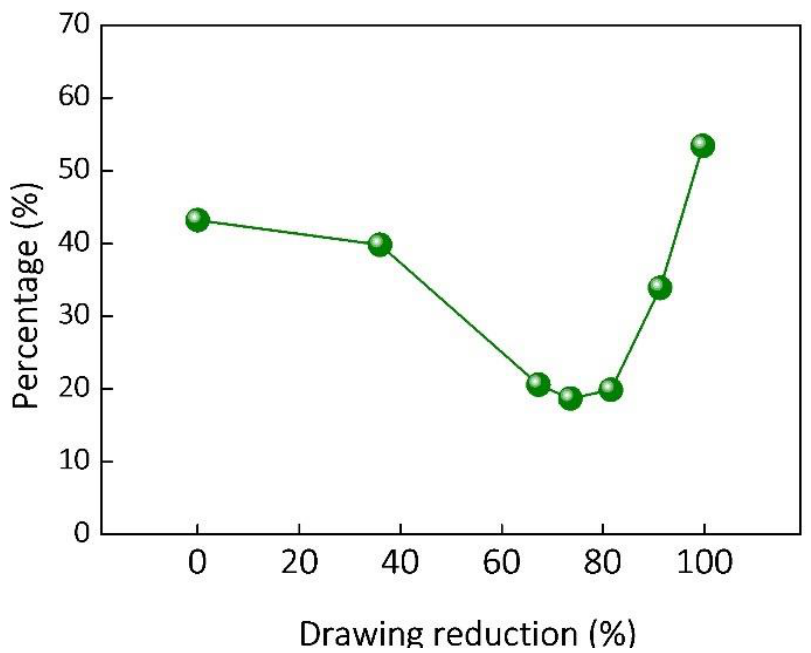
Figure 7. Percentage of HAGBs of the composites with different drawing reductions.